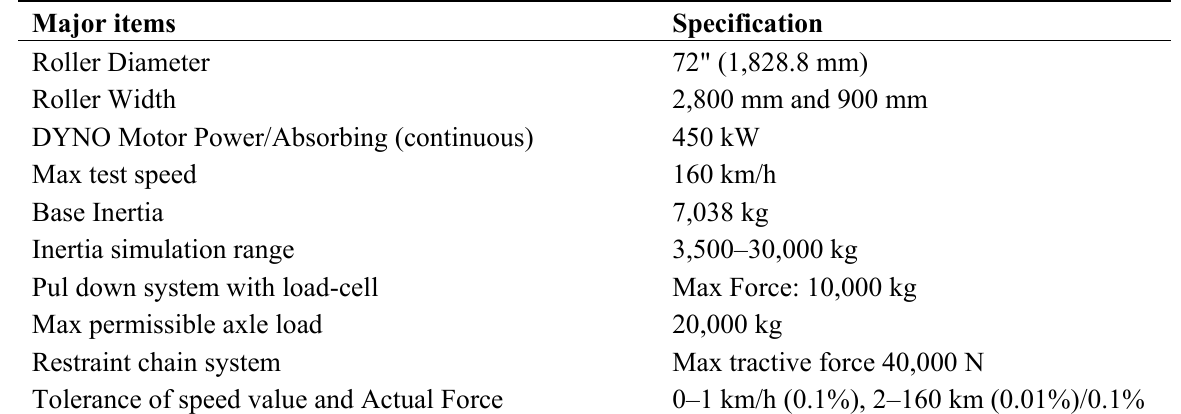
Table 2. Specifications of HDV chassis dynamometer.